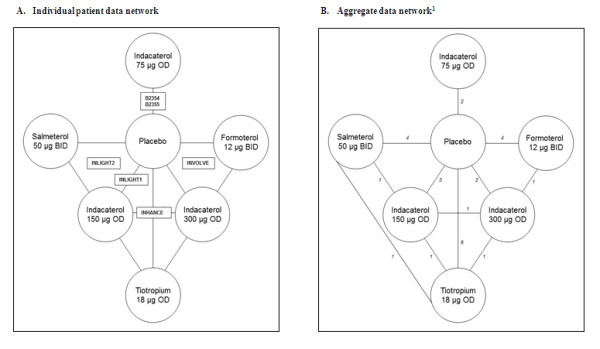
 Network of evidence.1Note: Two 3-arm trials and one 4-arm trial were included and counted separately; therefore totals do not sum to 22.